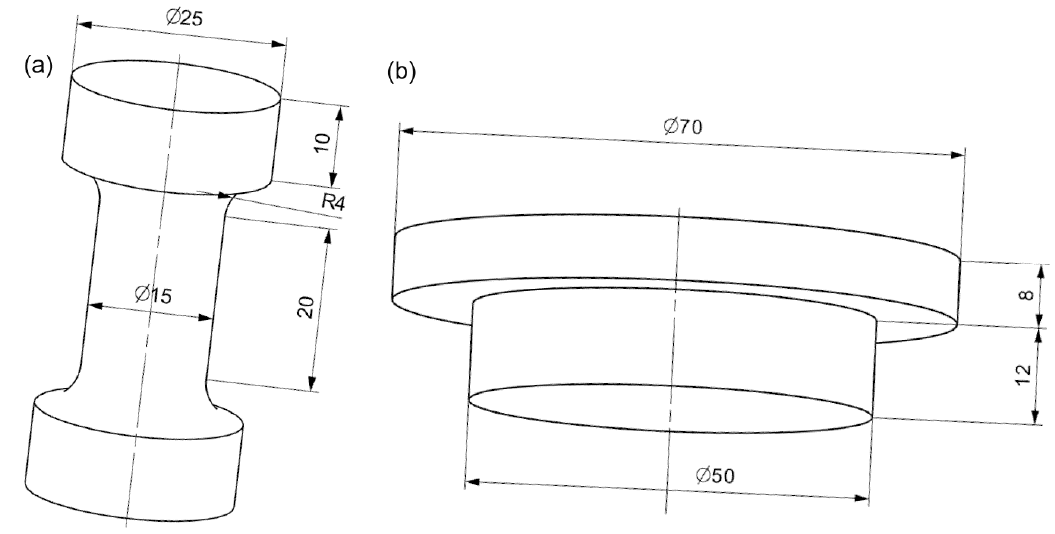
Figure 1. Specimen geometries: ( a ) barbell specimen and ( b ) gripper stamp specimen. Dimensions are in mm; R: radius.